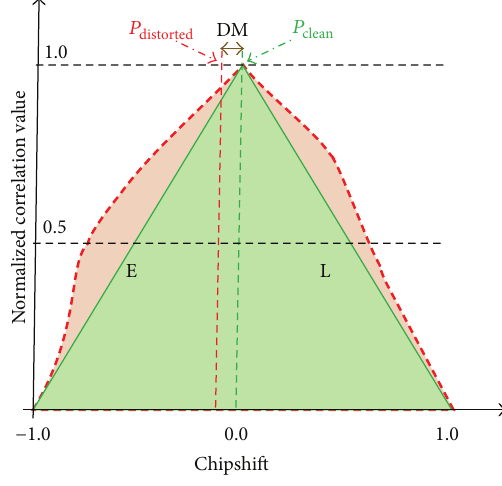
Figure 3: CCF distortion